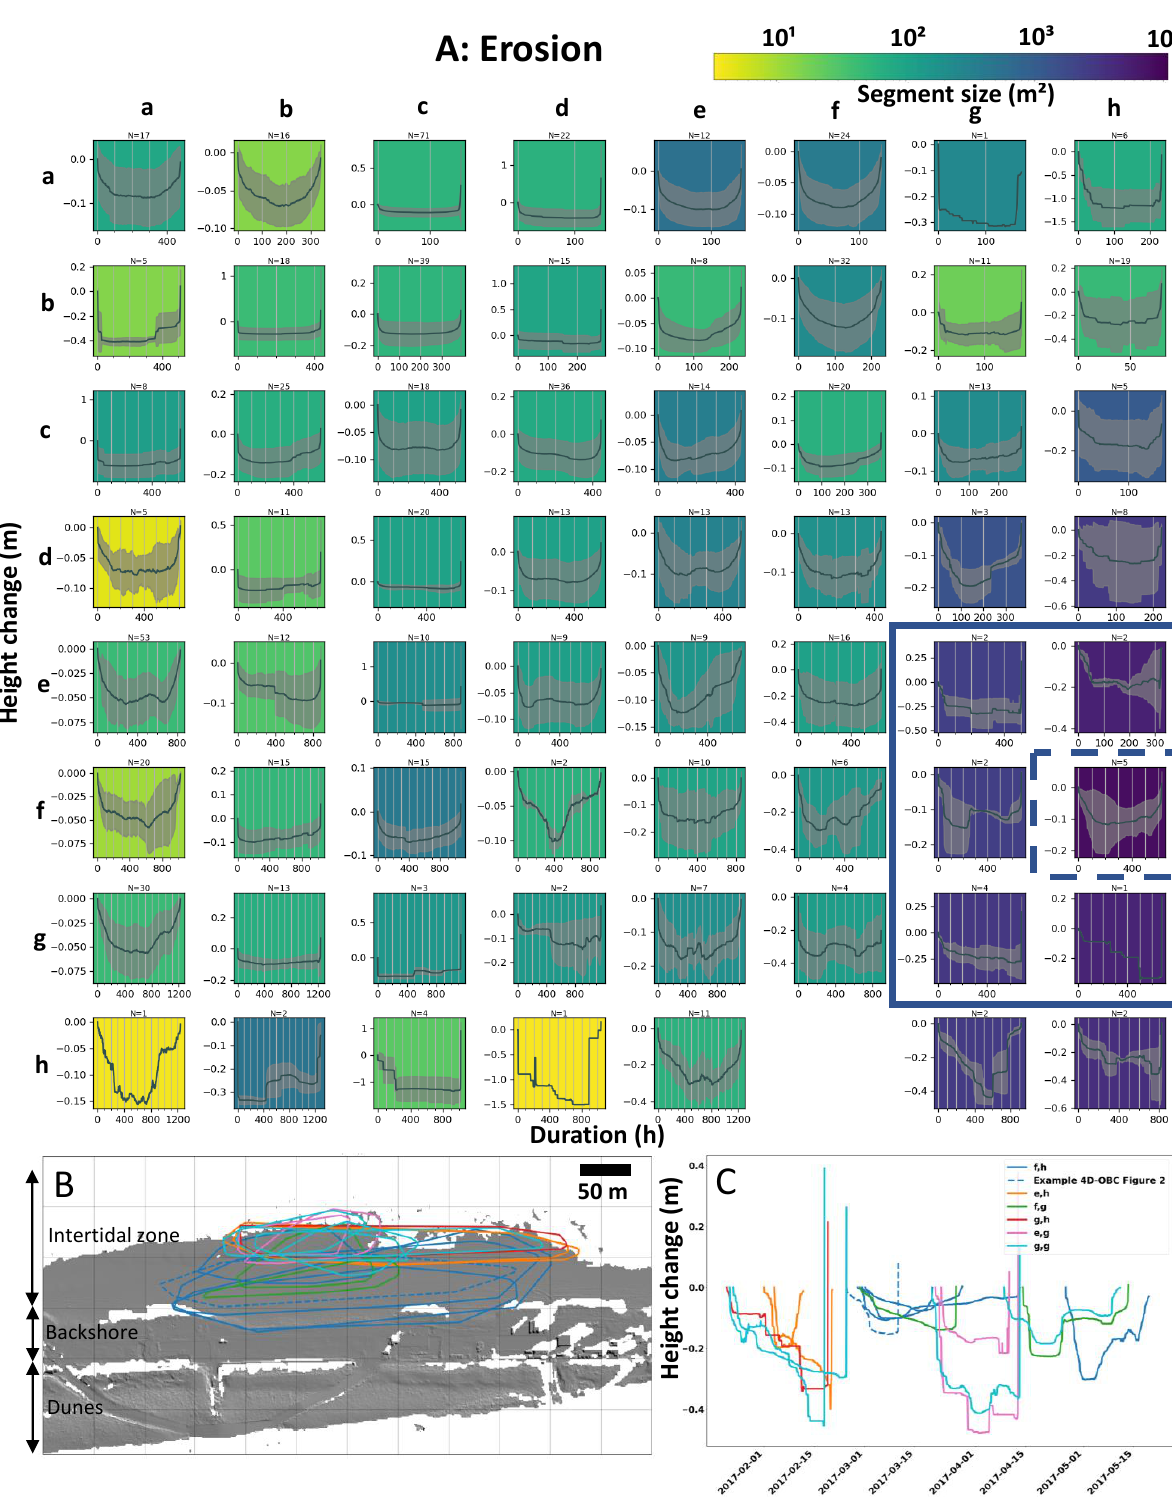
Figure 4. A) Visualization of the erosion Self-organizing Map (SOM E). Each plot represents a SOM node. The x-axis of each plot represents the mean duration of the 4D objects-by-change (4D-OBCs) in the node. The y-axis of each plot represents the mean height change of the 4D-OBCs in the node. The limits of both vary between each graph. The black curves show the mean time series of the 4D-OBCs in each node, and the grey area the standard deviation. The background colors represent the mean segment size per node (on a logarithmic scale). Nodes where no graph is visible represent nodes where no sample is matched after training. B) shows the convex hulls of the 4D-OBCs found in the nodes inside the blue polygon in A. The example shown in Figure 2 is visualized with a blue dotted line. C) shows the seed time series and timing of the 4D-OBCs as in